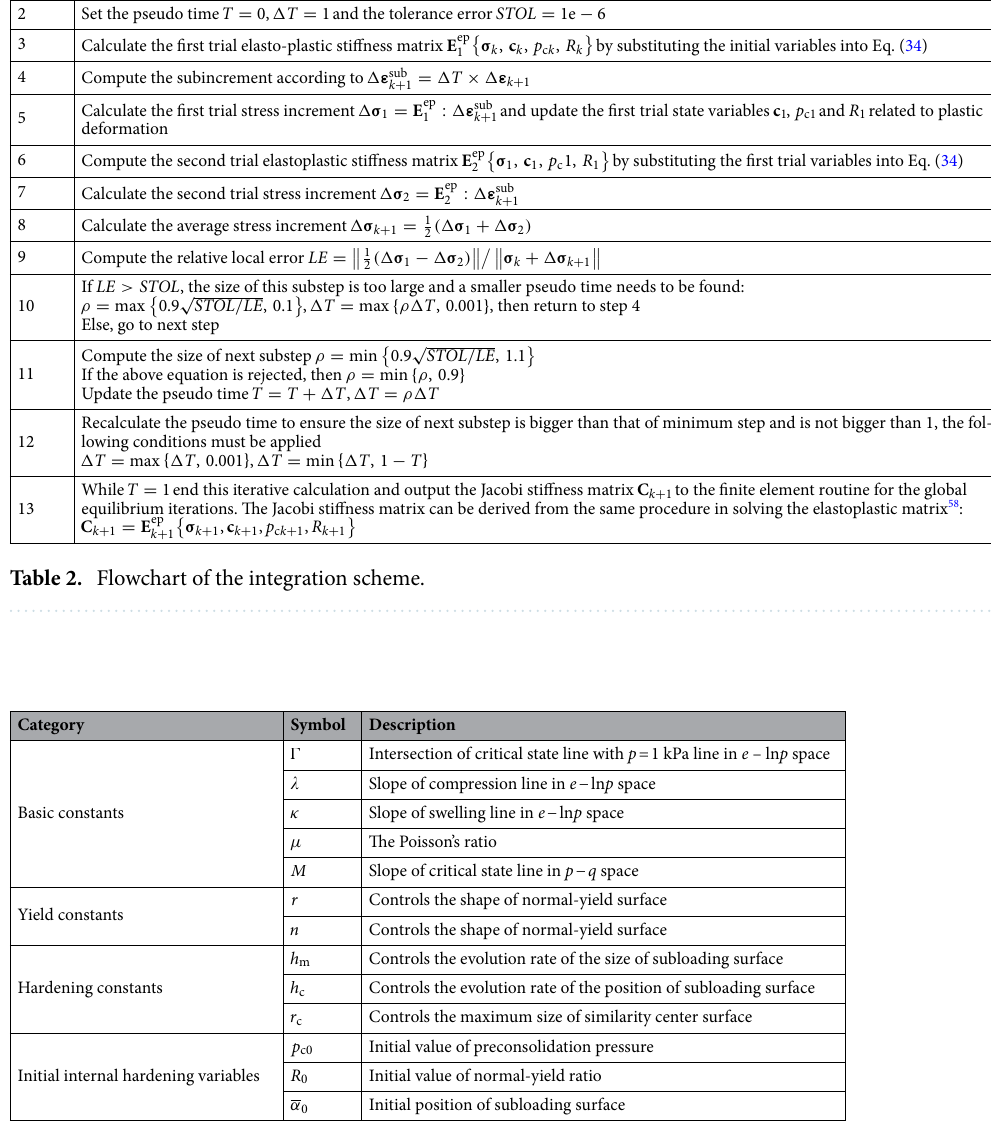
Table 3. Model constants in